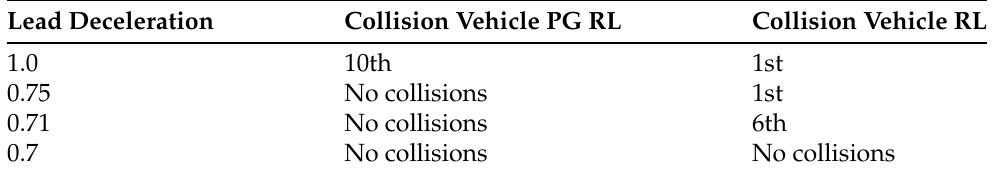
Table 2. Collision safety comparison between the traditional RL and the proposed PG RL